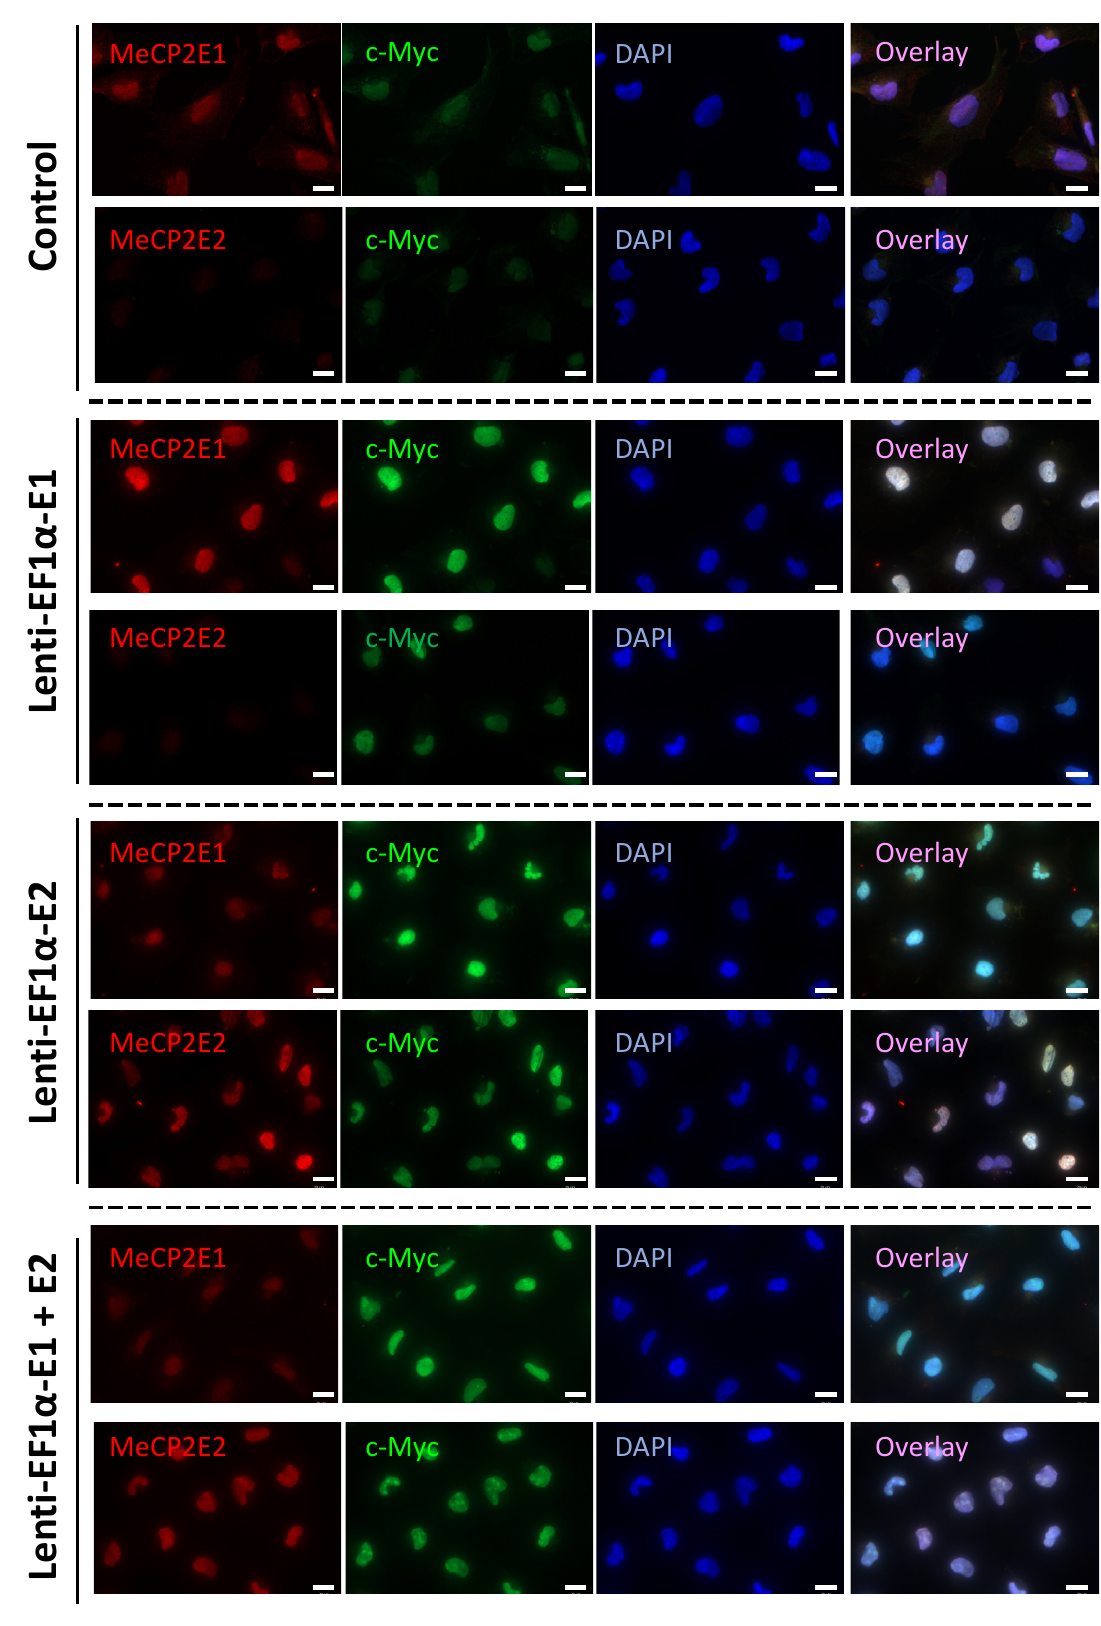
Figure 2. Immunofluorescence imaging of transduced Daoy cells. Control and transduced cells with indicated lentiviruses are shown. Scale bar represents 20 µm.